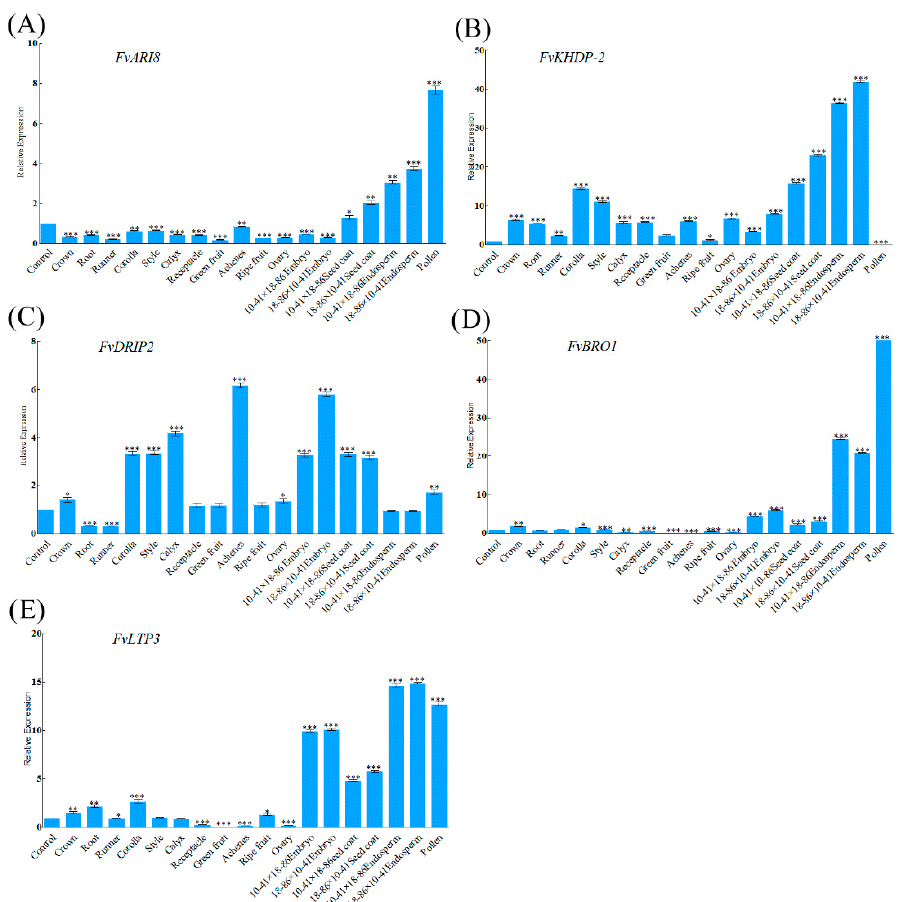
Figure 2. Expression of five imprinted genes in different tissues of F. vesca . Error bars represent standard deviation (SD). Columns with asterisks indicate significant difference: * represents p ≤ 0.05, ** represents p ≤ 0.01, *** represents p ≤ 0.001. FvARI8 ( A ), FvBRO1 ( D ), FvKHDP-2 ( B ), and FvLTP3 ( E ) showed a similar expression pattern, whereas FvDRIP2 ( C ) has a lower expression level in endosperm and pollen.